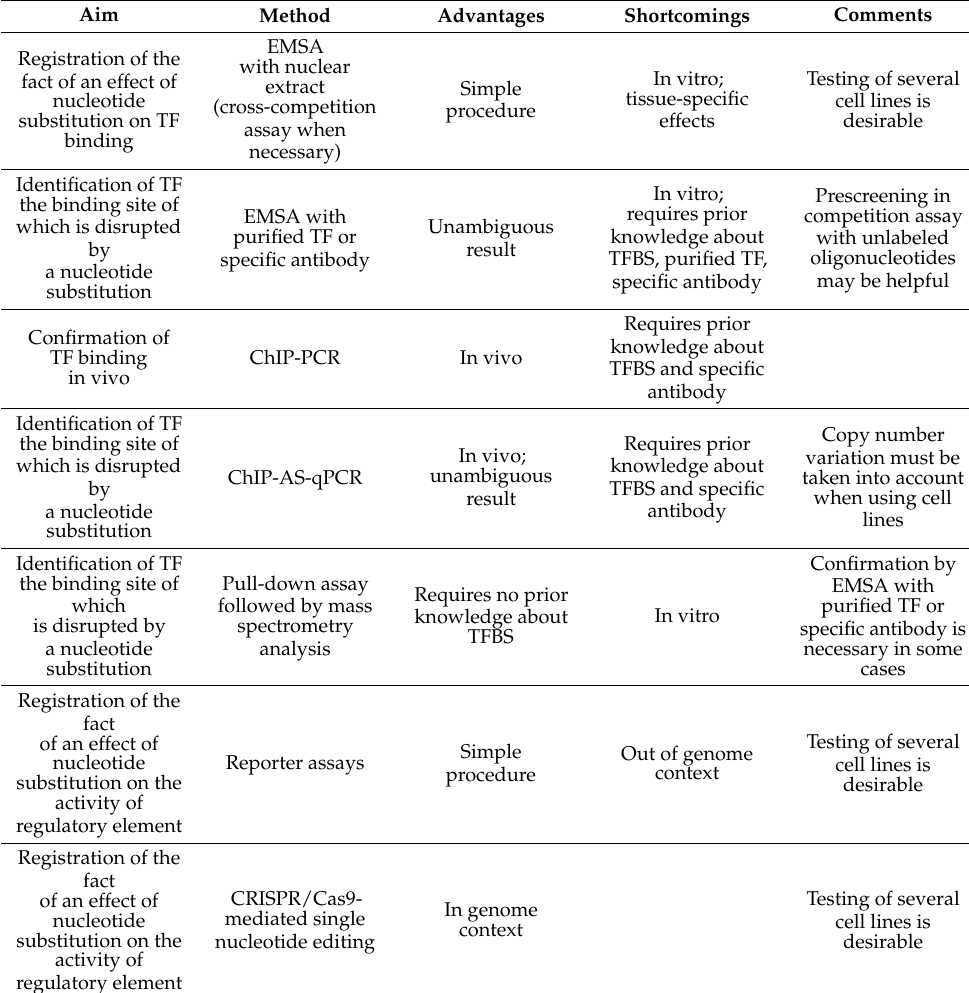
Table 1. Experimental methods for analysis of